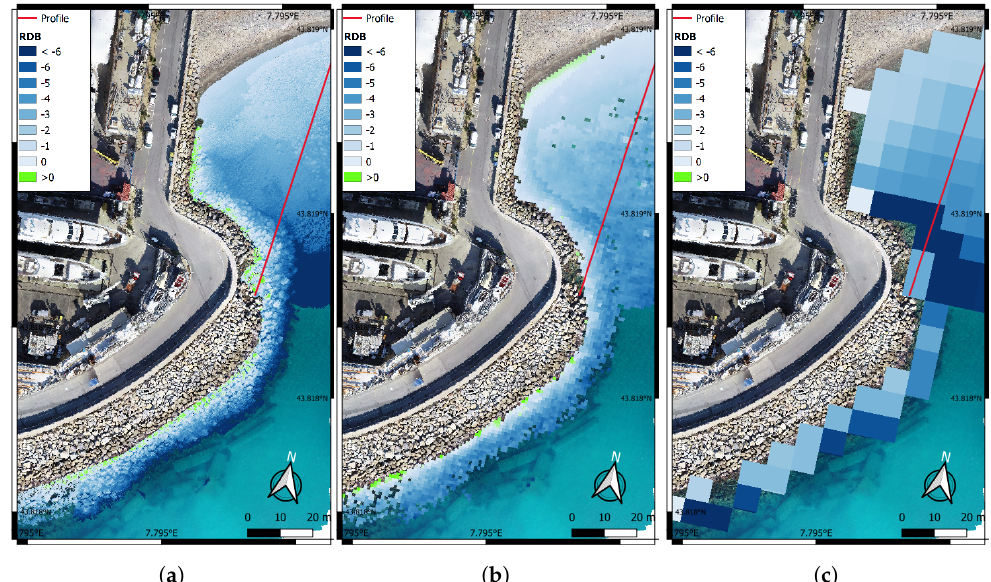
Figure 18. RDB results for ( a ) UAV, ( b ) aircraft and ( c ) S-2 orthophotos showing depth values derived at three different resolutions, 0.1 m, 1 m and 10 m, respectively. The red line indicates a transect used for bathymetry comparison in the following. The UAV-derived orthophoto is used as the background. Portosole extended area (beach area excerpt).